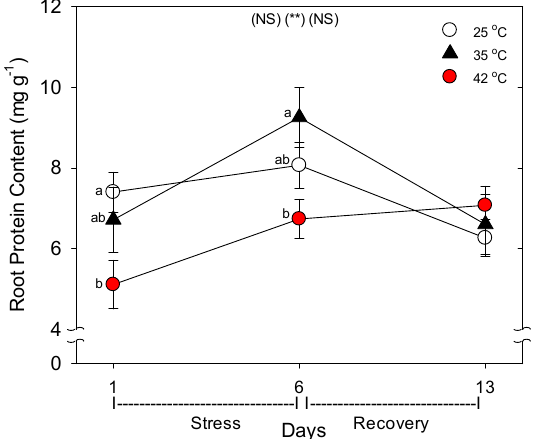
Figure 3. Effect of abrupt heat stress on protein content per gram (fresh weight) of roots. Plants were grown at 25 °C/20 °C day/night (control), and then subsets of plants were heat stressed at 35 °C/30 °C or 42 °C/37 °C day/night for one or six days (maximum root temperatures = 32 °C or 39 °C), and then returned to control conditions for seven days of recovery (=day 13). Values are means ± 1 SE for four independent replicates from each harvest (days 1, 6, 13). Statistics are as in Figure 1. ** p < 0.01.